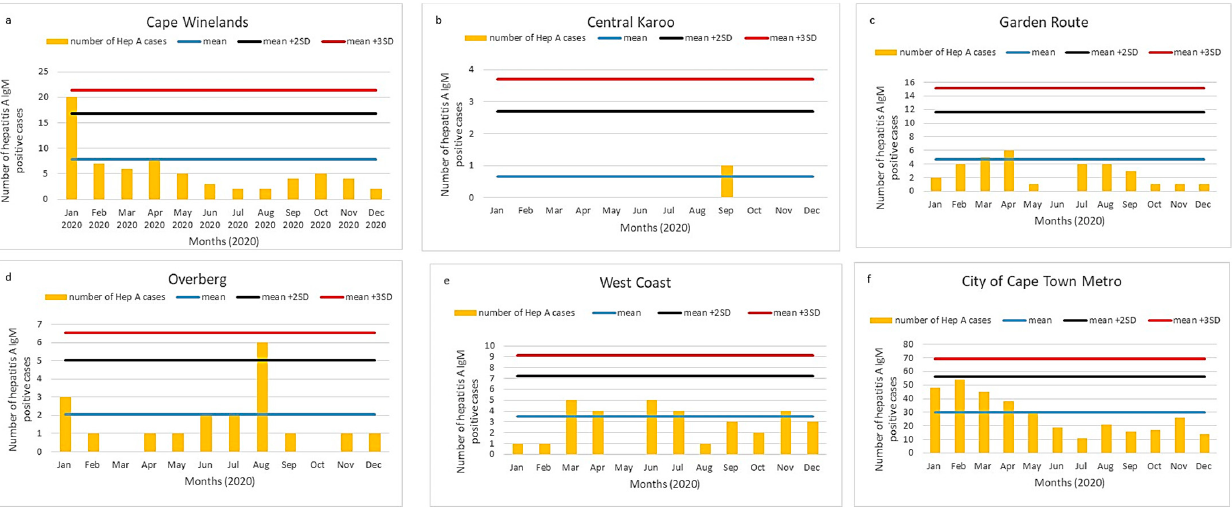
Figure 5. ( a – f ) Number of acute hepatitis A cases per district, Western Cape province, 2020. Number of acute hepatitis A cases (orange bars) are shown in comparison with the mean and two (black line) or three (red line) standard deviations of 2017–2019 data. A peak was noted in the Overberg district in August.